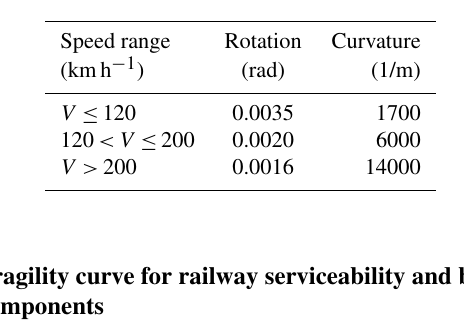
Table 3. Maximum angular variation and minimum radius of cur-